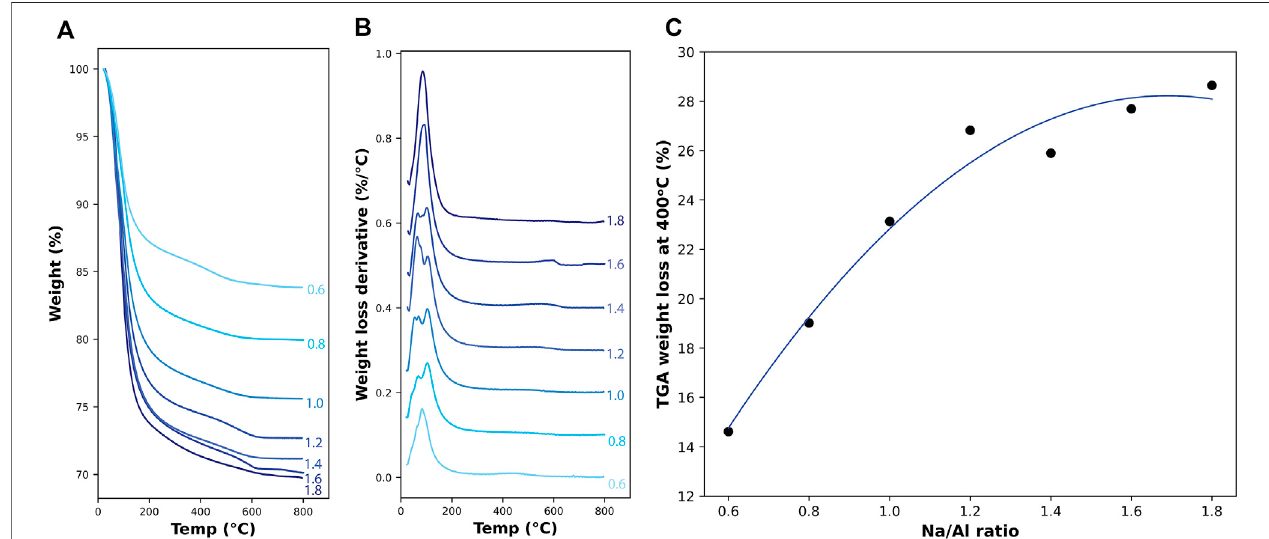
FIGURE 4 | TGA results on 3 month old AAM samples. (A) shows the percentage of weight loss and (B) shows the derivative weight loss with increasing temperature up to 800 ° C. (C) shows the total percentage of weight lost in the samples at a temperature of 400 ° C for different Na/Al ratios, with a second-degree polynomial best fi t